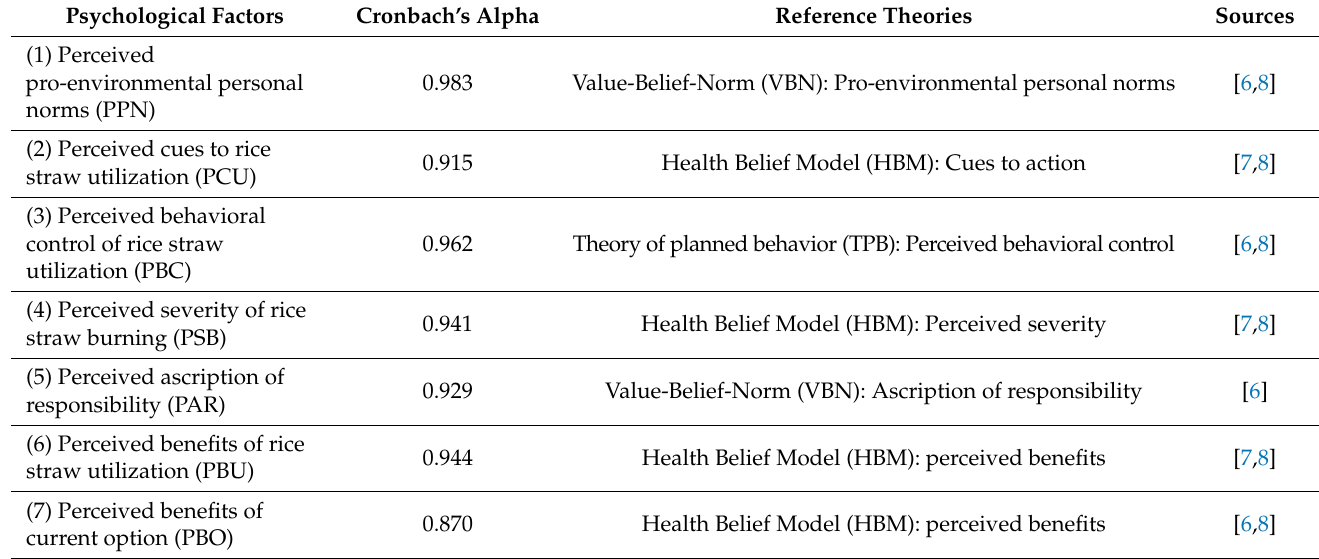
Table 1. Psychological factors, variables, reliability test and reference